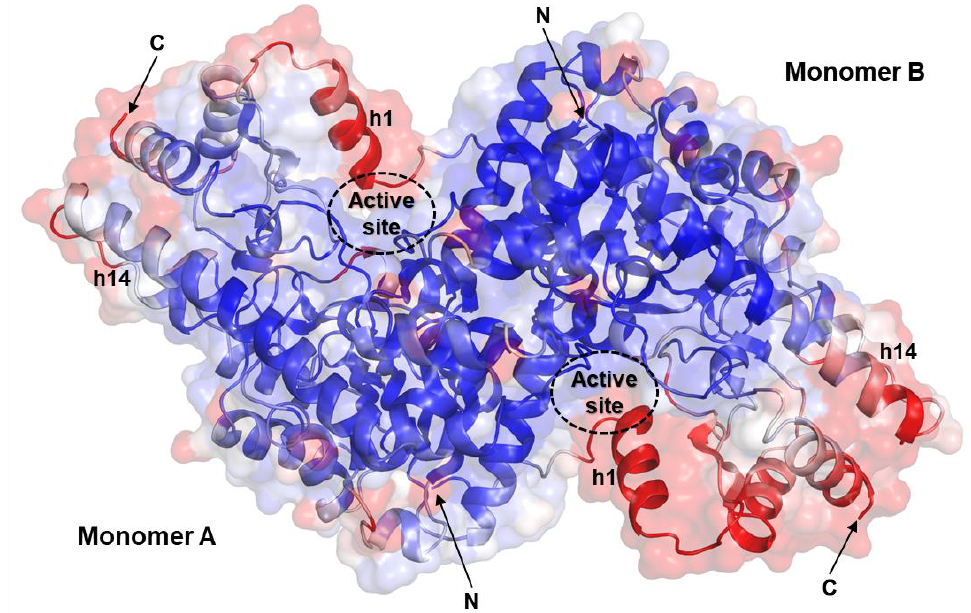
Figure 10. Atomic displacement parameters of Psy ArAT dimer (PDB ID: 4RKC); the low B-factors are colored in navy blue, and the high B-factors are colored in red.